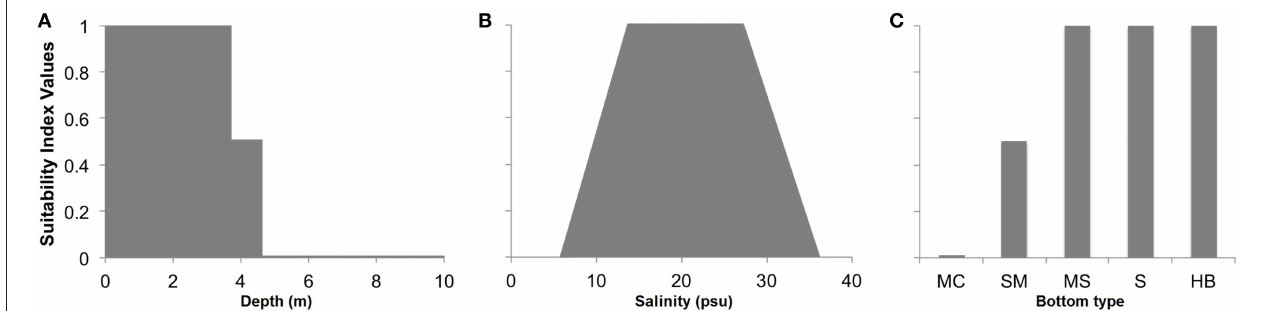
FIGURE 2 | Relationships between the actual value of environmental variables and associated habitat suitability values for (A) water depth (surrogate variable for dissolved oxygen), (B) salinity, and (C) bottom type (MC, muddy clay; SM, sandy mud; MS, muddy sand; S, sand; HB, hard bottom; listed in order of increasing grain size). Scores of 0 are unsuitable and values of 1 are optimal.